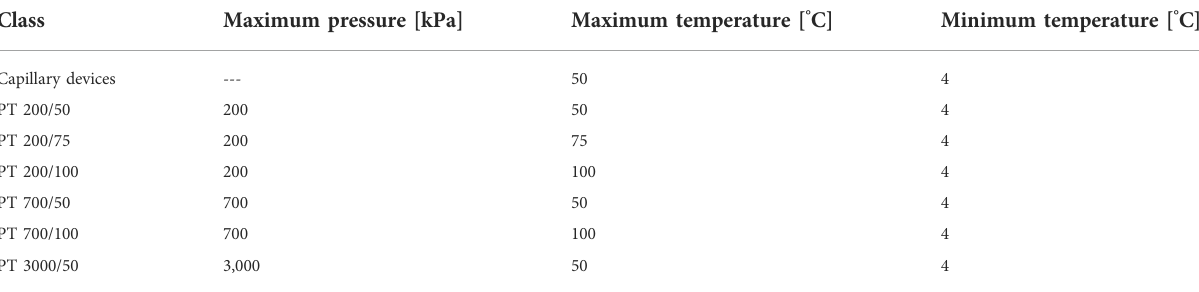
TABLE 5 These proposed application classes based on operating conditions have been adapted from ISO 22916:2022 (International Organization for Standardization, 2022).